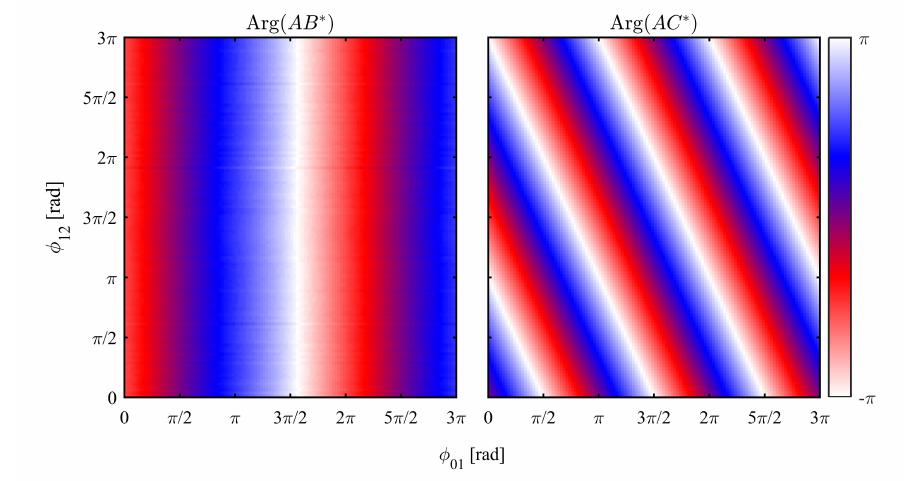
Figure 4. The relative phases between the complex amplitudes A , B , and C of the qutrit wavefuction as afunctionoftheSTIRAPphases φ 01 and φ 12 ,with α = cos ( π /8 ) , β = − i sin ( π /8 ) , Ω t s / σ = 2, and σ = 50 ns. The simulation agrees with the analytical results Equations (20) and (21) obtained in the adibatic approximation.